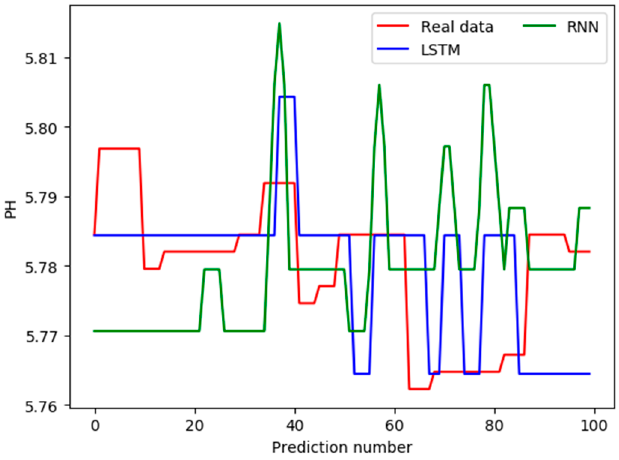
Figure 14. Comparison between predicted values and real values.